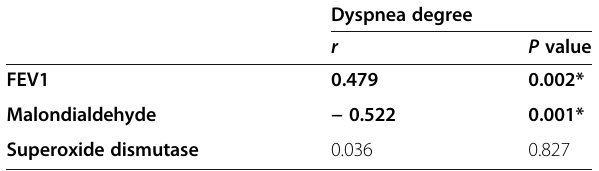
Table 7 Correlation between oxidative stress biomarkers, FEV1 and dyspnea grade